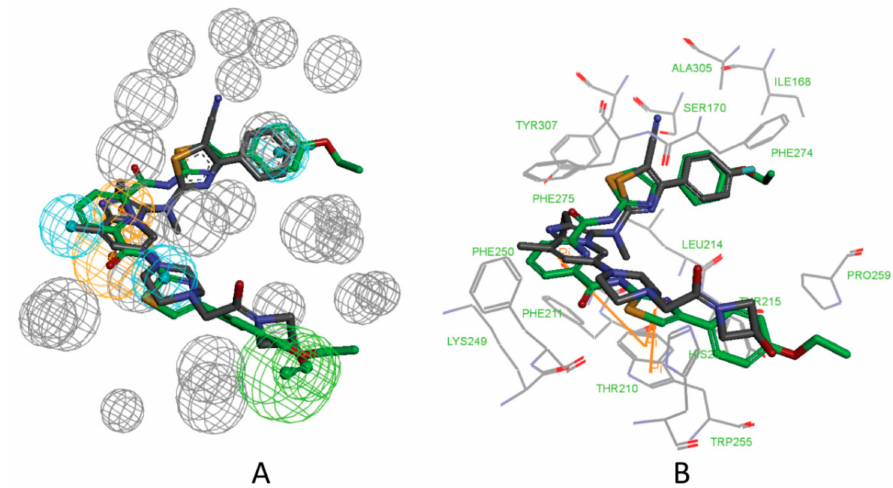
Figure 11. ( A ) Mapping of 5MHP 03 with compound cpd7. ( B ) The possible binding pose of cpd7 in the autotaxin active site. Compound 7NB complexed with autotaxin is also shown for comparison (in gray stick form).